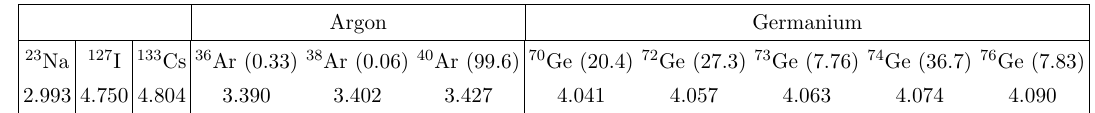
X i R i , where X i and R i stand for p p i